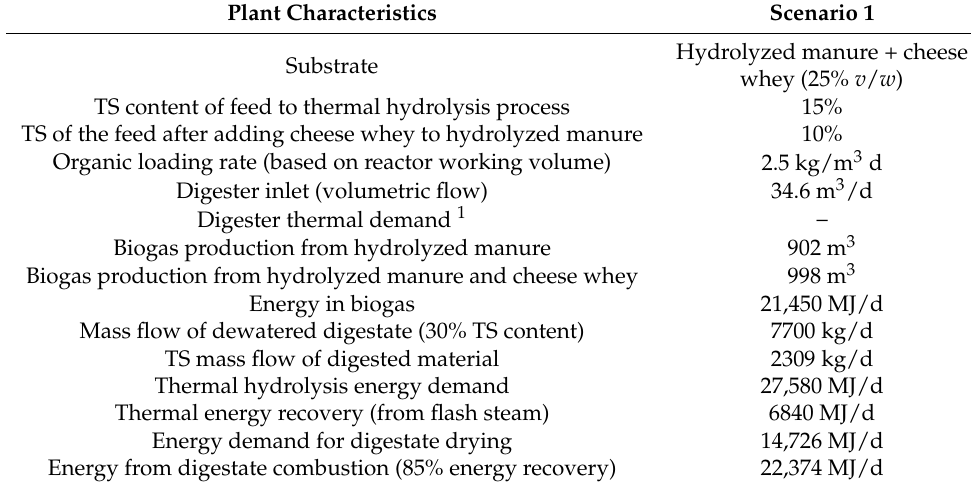
Table 4. Main calculated parameters of the integrated system: thermal hydrolysis and anaerobic digestion, Scenario 3. Hydrolyzed manure and cheese whey (25% v / w ) used as